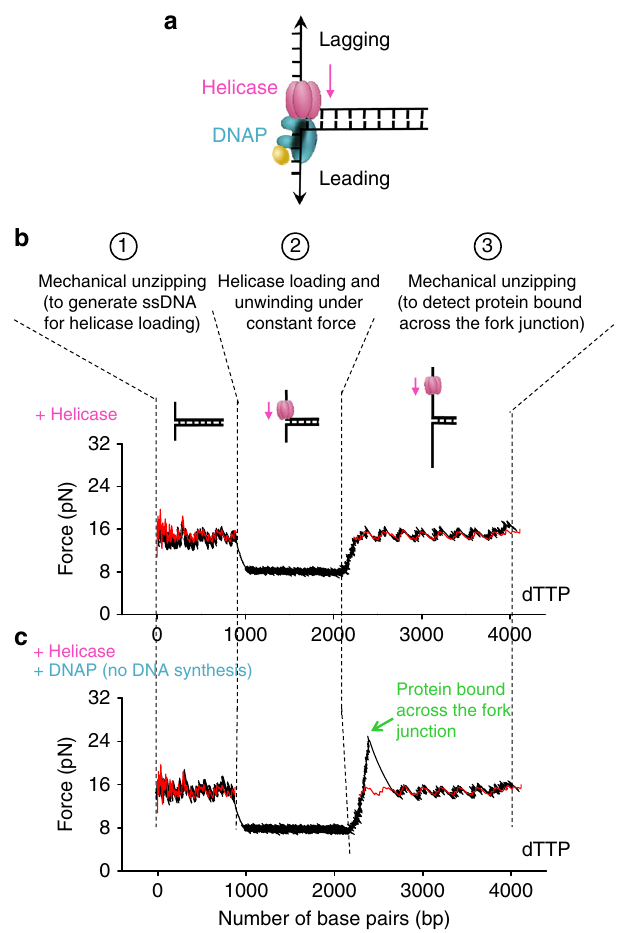
Fig. 2 Non-replicating DNAP localizes to the fork with the helicase. a A cartoon illustrating helicase-DNAP coupling. A non-replicating DNAP directly interacts with an unwinding helicase. The helicase – DNAP complex is juxtaposed crossed the fork junction. b , c Representative traces showing the force vs. number of base pairs unzipped/unwound in presence of helicase and 2 mM dTTP, either without or with the presence of non- replicating DNAP, respectively. The red curves correspond to unzipping naked DNA. The green arrow indicates a force peak above the naked